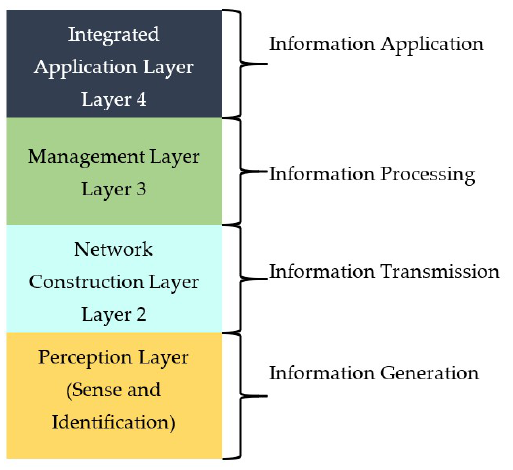
Figure 8. Four-layered architecture for IoT.